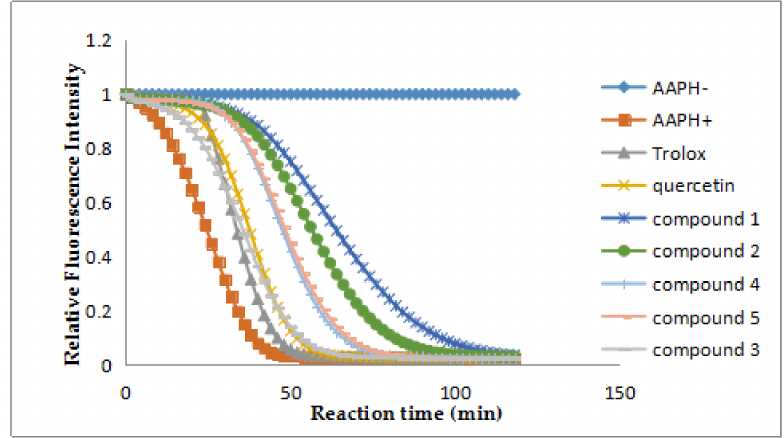
Figure 5. Fluorescence decay curves induced by AAPH in the presence of compounds 1 – 5 at 1 µ